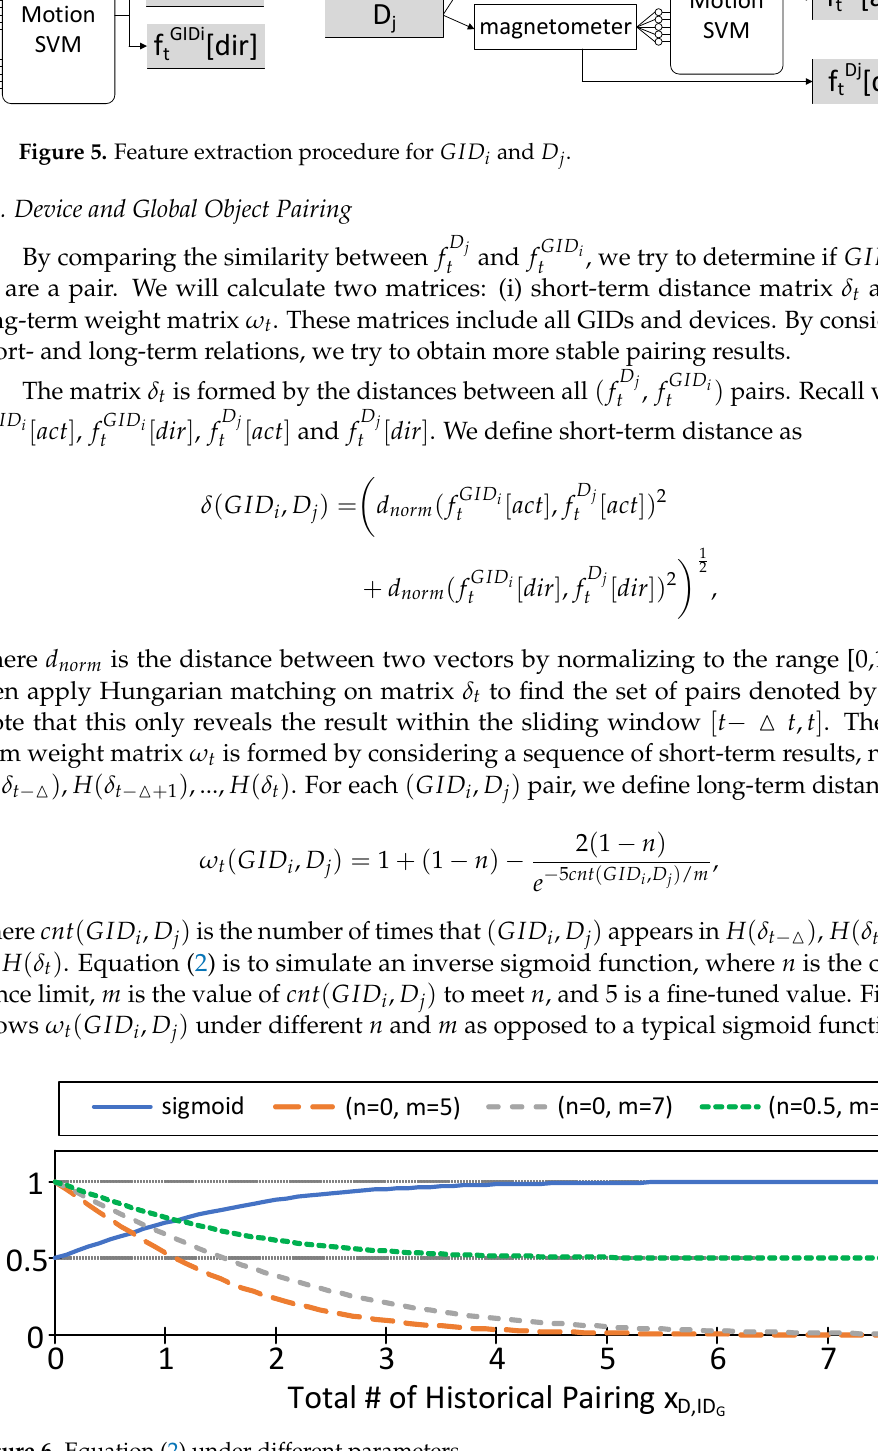
Figure 6. Equation (2) under different